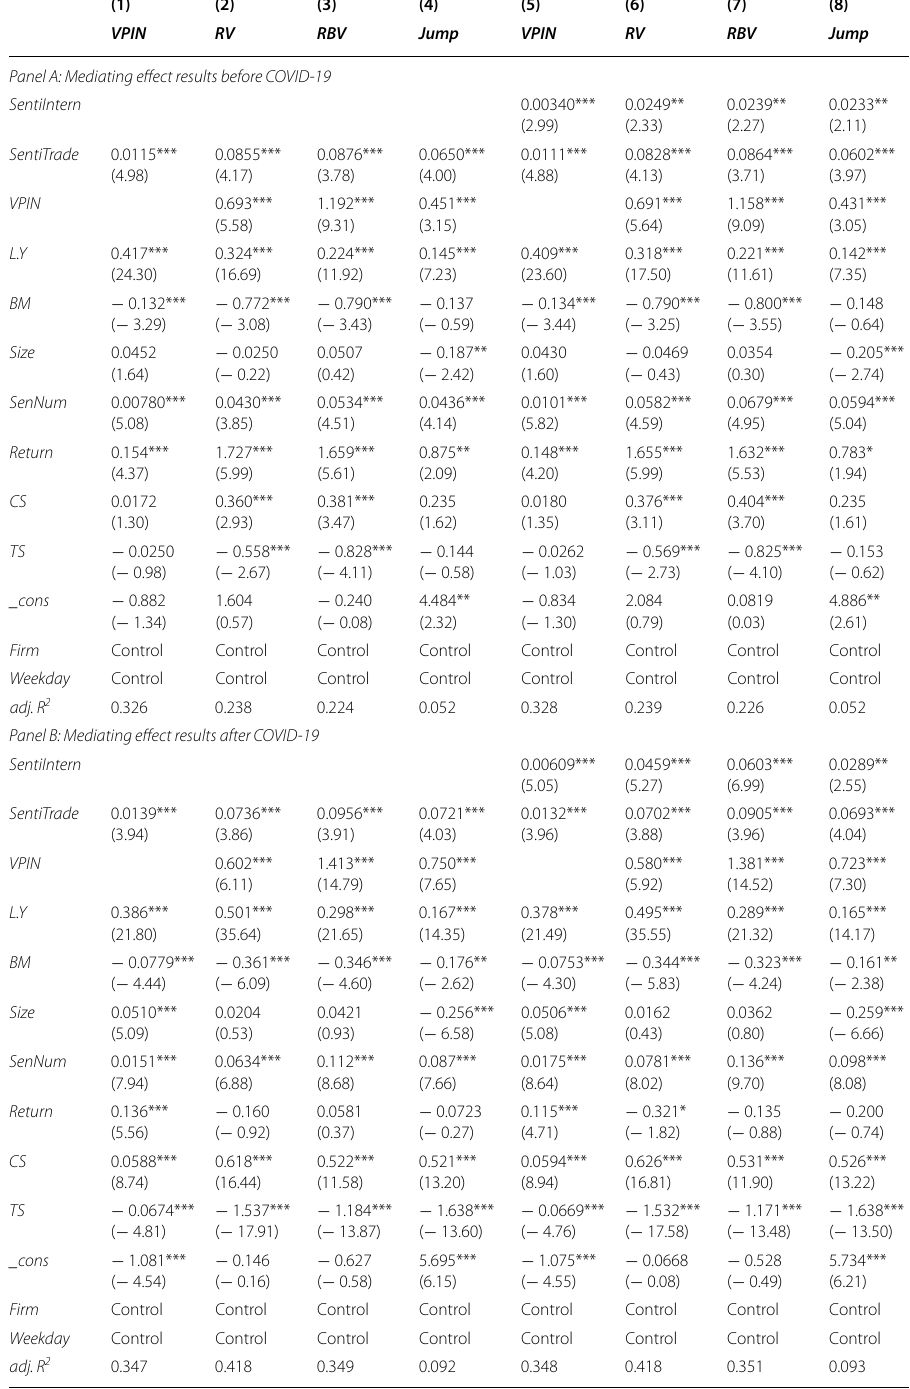
Table 10 Results of mediation effect model before and after the COVID-19